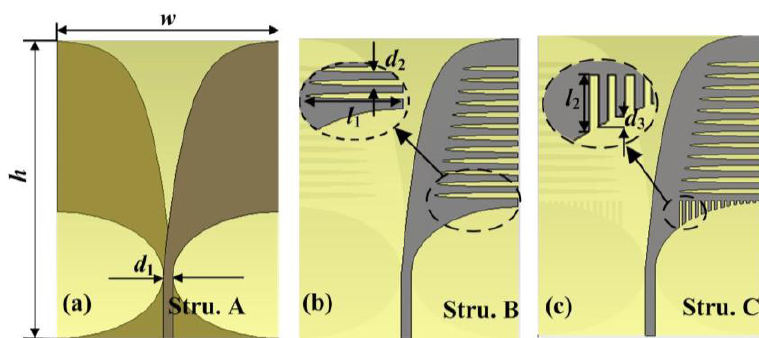
Figure 3. ( a ) The typical antipodal Vivaldi antenna (AVA). ( b ) The tentative plasmonic AVA. ( c ) The final plasmonic AVA. The dimensions of the antenna: R = 0.16, h = 94 mm, w = 70 mm, l 1 = 26 mm, d 1 = 2.5 mm, d 2 = 1.25 mm, l 2 = 8.02 mm, and d 3 = 2 mm.